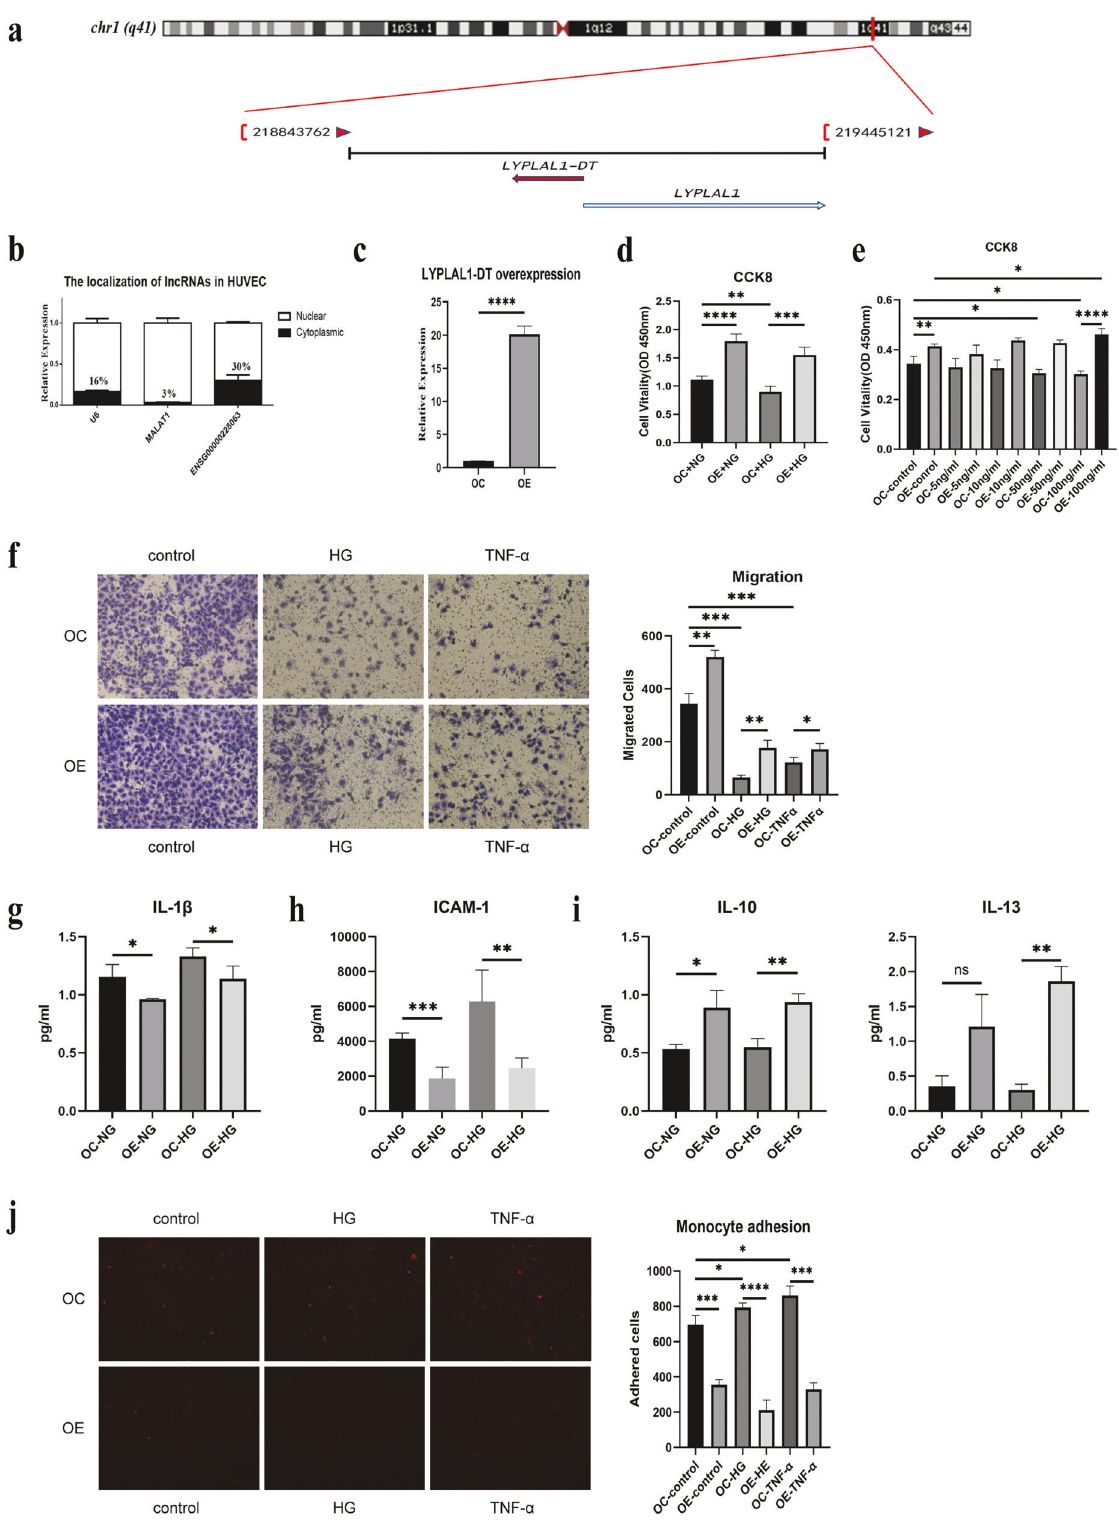
Fig. 4 The location of LYPLAL1-DT and the biological function of LYPLAL1-DT in HUVEC. a The location of LYPLAL1-DT on the chromosome. b The Subcellular localization of LYPLAL1-DT in HUVEC. c Establishment of LYPLAL1-DT-overexpression cell line with a pLenti-GIII-CMV-CBH-GFP-2A- Puro vector being transfected into HUVEC was identi fi ed by real-time PCR. d , e CCK-8 assays were performed to determine the viability of LYPLAL1- DT-overexpressing cells treated with HG (25 mM) or induced by TNF- α for 12 h. f Transwell assays were used to investigate the migration of LYPLAL1-DT-overexpressing cells treated with HG (25 mM) or induced by TNF- α (100ng/ml) for 12h. g , h , i The HG-treated and TNF- α -induced cell culture medium were collected to detect the expression levels of cytokines, including IL-1 β , ICAM-1, IL-10, and IL-13, using ELISA Kits. j LYPLAL1-DT- overexpression HUVECs were pretreated with HG or TNF- α as described above, then adhered Dil-stained THP-1 cells were visualized by fl uorescence microscopy. “ * ” indicated signi fi cant difference with p <0.05, “ ** ” indicated p <0.01 and “ *** ” indicated p <0.001. Cell Death Discovery (2022)